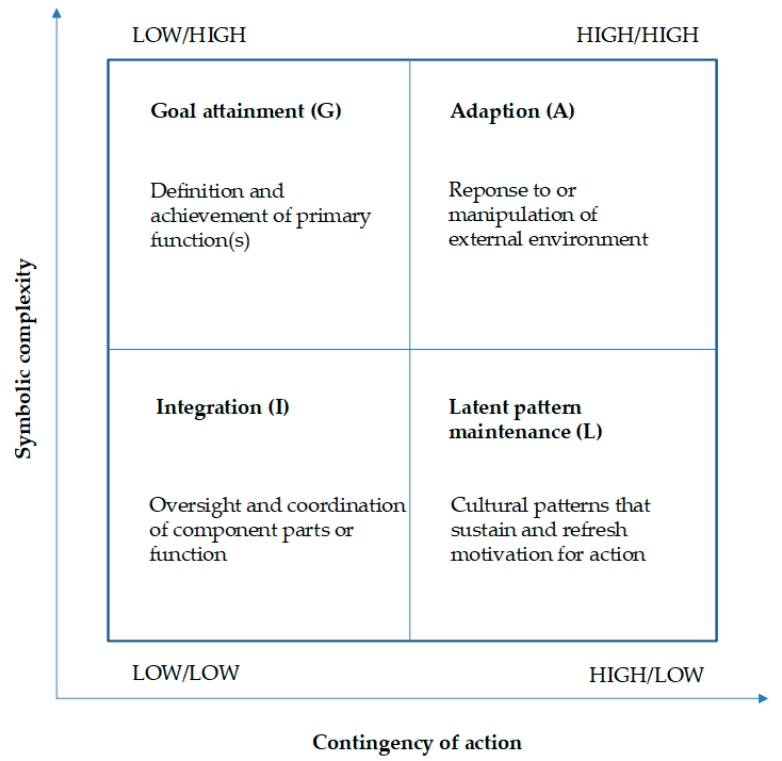
Figure 1. Authors’ adaption of the AGIL scheme from T. Parsons’ model, with four quadrants corresponding to the four dimensions of the scheme.